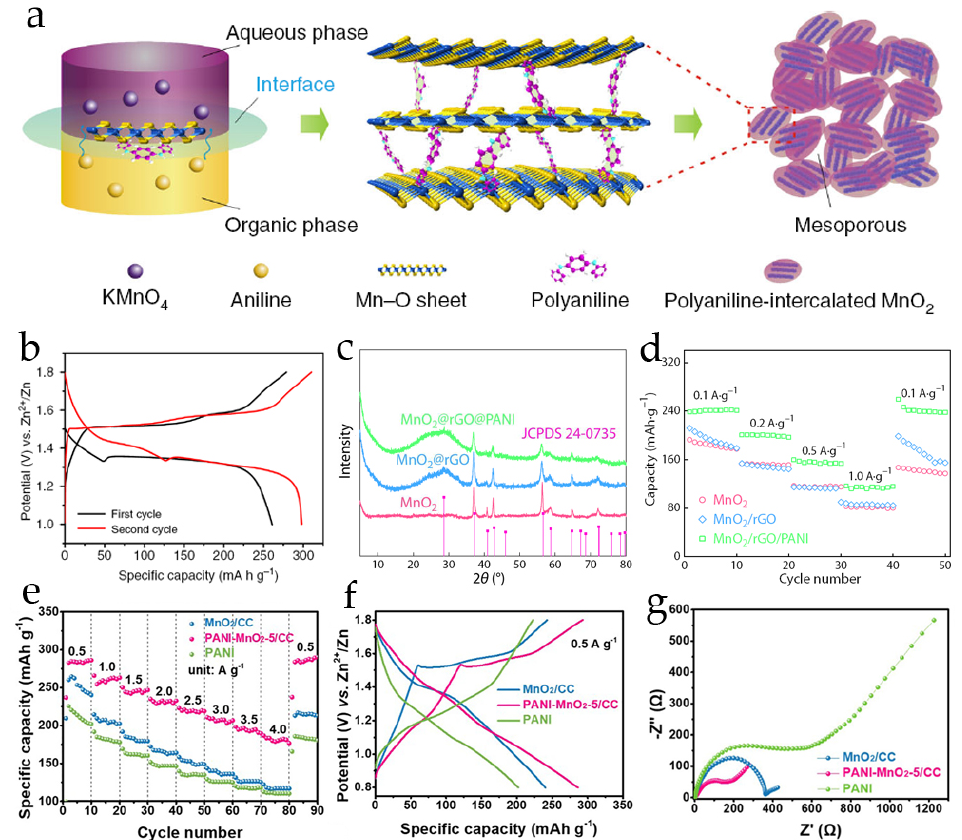
Figure 9. ( a ) Scheme of the reaction between aniline and potassium permanganate and the expanded structure of PANI-intercalated MnO 2 nanolayers [66]. ( b ) Typical galvanostatic charge/discharge curves of PANI-intercalated MnO 2 cathode at 0.05 A·g − 1 [66]. ( c ) XRD patterns and ( d ) C-rate capabilities of MnO 2 , MnO 2 /rGO, and MnO 2 /rGO/PANI composites [67]. ( e ) Rate performance and ( f ) Galvanostatic discharge/charge curves of MnO 2 /CC, PANI-MnO 2 /CC and PANI [68]. ( g ) Nyquist plots for MnO 2 /CC, PANI-MnO 2 /CC, and PANI [68].